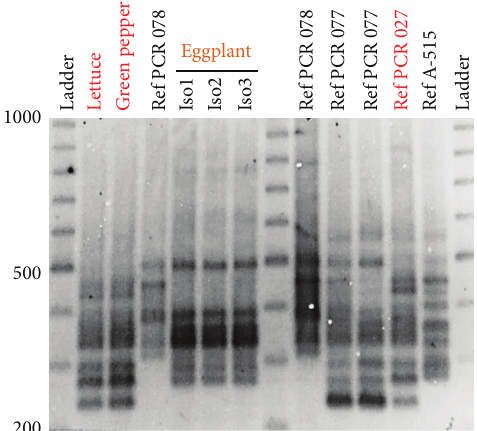
Figure 1: Toxigenic C. difficile strains isolated from fresh vegetables in Ohio. Illustration of PCR ribotyping of isolates and reference strains. This is the first isolation of PCR-027-like C. difficile from a sample of food or animal origin in the laboratory where this study took place. Laboratory cross-contamination was here quantified and thus deemed extremely unlikely. Reference strains PCR 027, 077, and 078 correspond to original isolates published by Rodriguez- Palacios et al. in 2006 which were characterized as relevant to the early 2000s epidemic outbreaks of CDIs in humans by Dr. J. Brazier at the Anaerobe Reference Laboratory for Clostridium difficile in Cardiff, UK [5]. All other reference strains correspond to isolates previously identified in animals in the USA [18, 37, 38]. Figure 2: Visual representation of MIC values and distinct antimi-